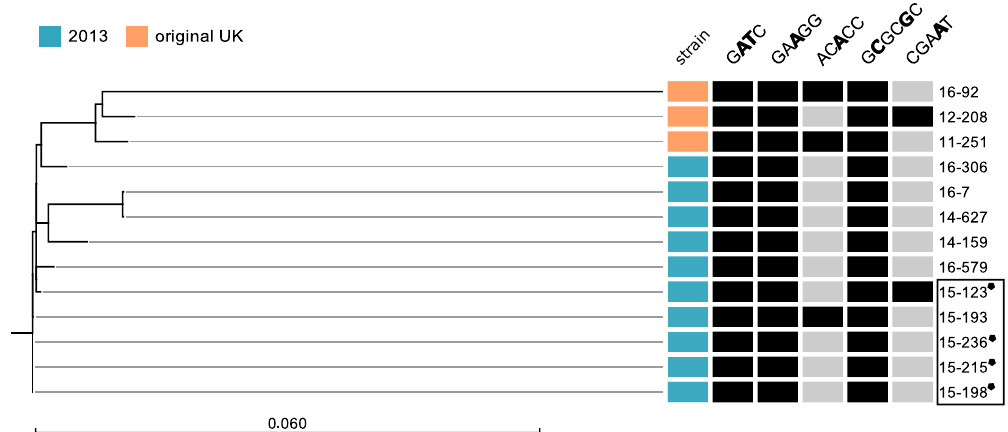
Figure 3. Phylogeny of the 13 N. meningitidis serogroup W isolates based on single-nucleotide polymorphisms (SNP), isolates belonging to the 2013 strain marked in blue and original UK strain in orange. Detected methylation motifs with single-molecule real-time sequencing are shown as black boxes. Isolates from the Jamboree outbreak are marked in a black box, carrier isolates are marked with a star-shaped